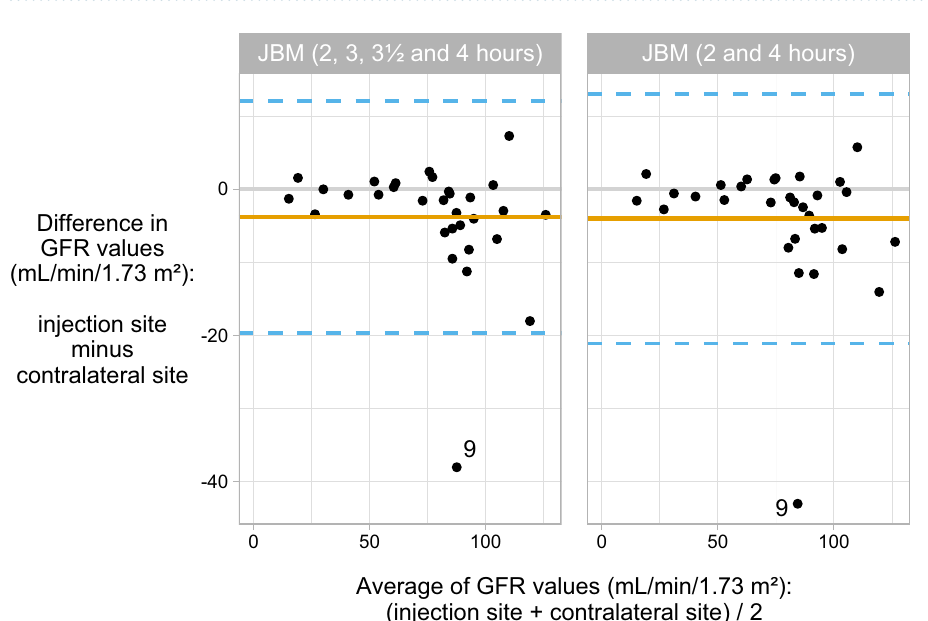
Figure 2. Bland–Altman plots of difference in measured iohexol-GFR (calculated by the Fleming 1-point formula) from samples drawn in parallel from both arms at four time points (2, 3, 3.5 and 4 h): mean bias (solid orange line) and limits of agreements (dashed blue line).